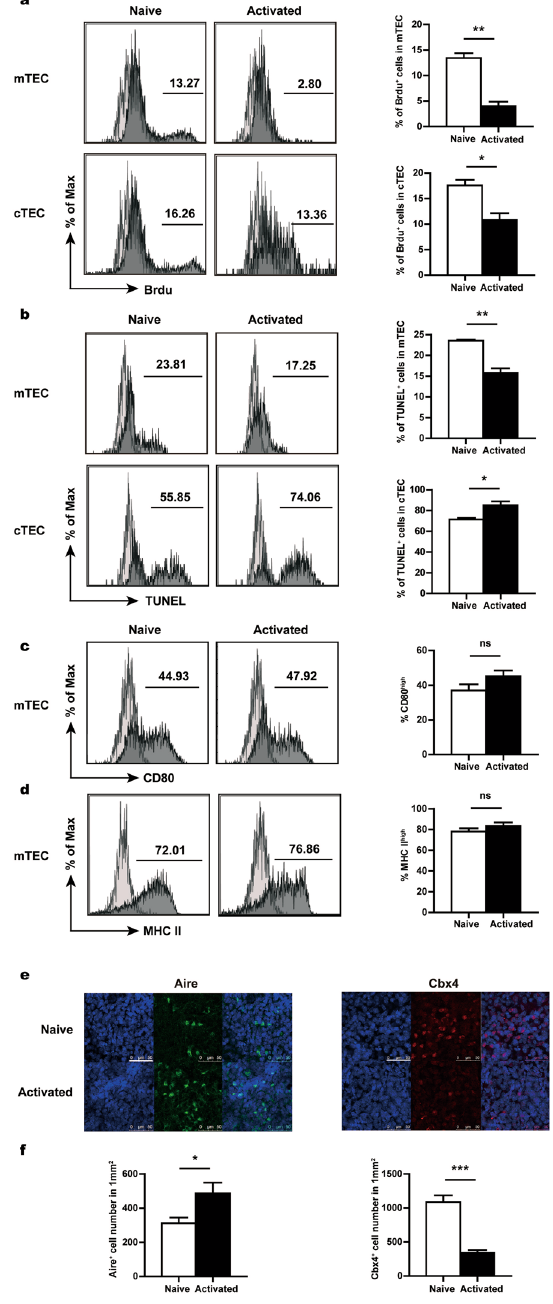
Figure 4. Inhibited TEC proliferation but enhanced mTEC production in the activated T cell-treated fetal thymus. Fetal thymuses were co-cultured with naive or activated CD4 + T cells for 12 days. mTECs were gated on CD45 − EpCam + Ly51 − cells and cTECs were gated on CD45 − EpCam + Ly51 + cells in flow cytometric analysis. ( a ) Brdu was added to the culture 24 hours before harvesting. Brdu incorporation was detected by flow cytometry. Representative histograms (left) and the percentage of Brdu + cells (right) are shown for mTECs (upper) and cTECs (lower), respectively. ( b ) TUNEL assay was performed to evaluate the apoptosis of mTECs (upper) and cTECs (lower). Representative histograms (left) and the percentage of TUNEL + cells (right) are shown. ( c ) The expression of CD80 in mTECs was measured by flow cytometry. Representative histograms (left) and the percentage of CD80 high cells (right) are shown. ( d ) Representative histograms of MHCII staining (left) and the percentage of MHCII high cells (right) in mTECs. Shallow shades represent the staining controls for different markers. ( e ) Immunofluorescent staining was performed to detect the expression of Aire and Cbx4. Co-staining was performed with Hoechst 33342. Scale bars: 50 μ m. Similar results were obtained from three independent experiments. Representative images are shown. ( f ) The number of Aire + (left) and Cbx4 + (right) cells were counted in 10 randomly chosen sections of 145 × 145 μ m 2 and then converted into cell number per mm 2 . Data from three independent experiments are presented as Mean ± SEM. * p < 0.05; ** p < 0.01; p < 0.001; and ns, not